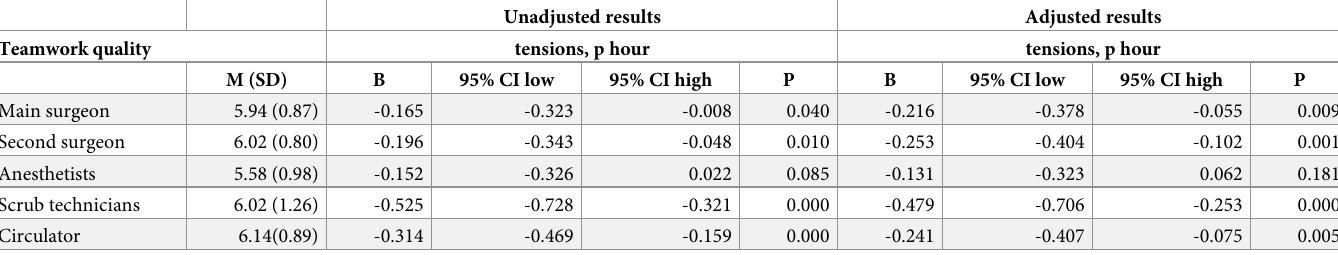
Table 5. Tensions per hour and perceived teamwork